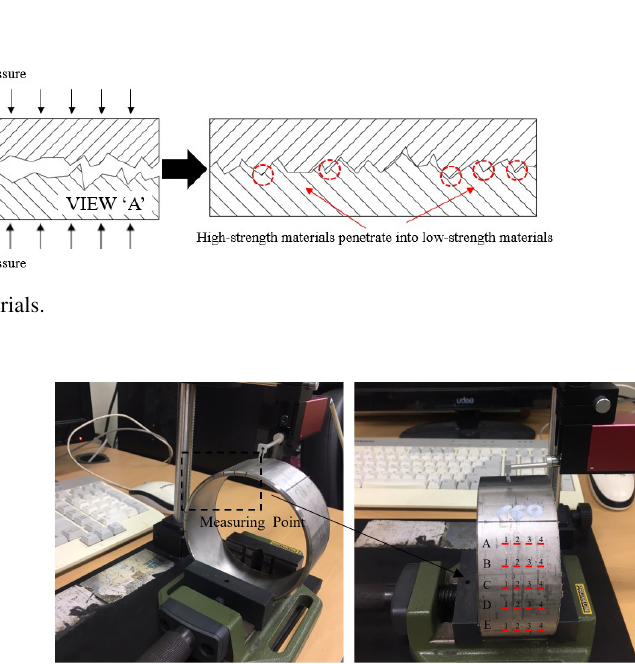
Figure 5. Photograph of the surface profile test and measurement of surface